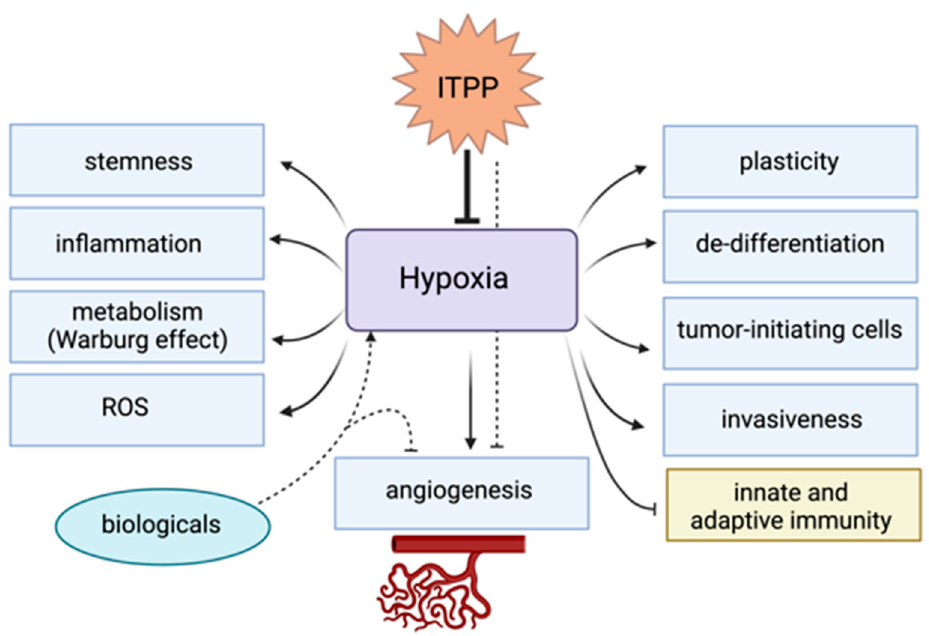
Figure 1. Hypoxia-mediated effects affecting various processes of tumors and the tumor microen- vironment. ITPP, myo-inositol-trispyrophosphate; ROS, reactive oxygen species.